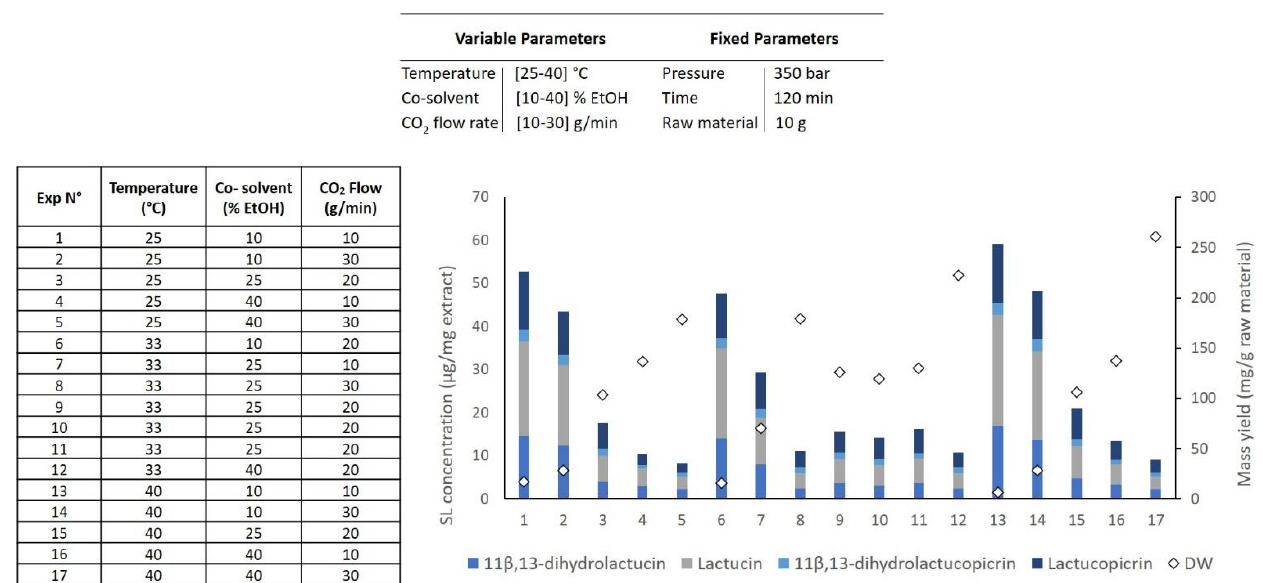
Figure 3. The extraction of SL was carried out following a Central Composite Face-Centered Design (DOE #2) as a function of pressure, temperature, flow rate and co-solvent percentage. Experiment numbers (1 – 17) correspond to the extraction number assay, white diamonds (values linked to right axis) represent extraction mass yield and coloured bars (values linked to left axis) represent the concentration of the major SLs extracted from Cichorium intybus L . roots from supercritical CO 2 extraction process. Table 2. Model equations for the response surfaces, after final SFE optimization (DOE 2), fitted to the values of mass yield (MY) and the four major SLs extracted as a function of temperature (A), co-solvent percentage (B), and flow rate (C), and their respective R 2 and R adj2 .